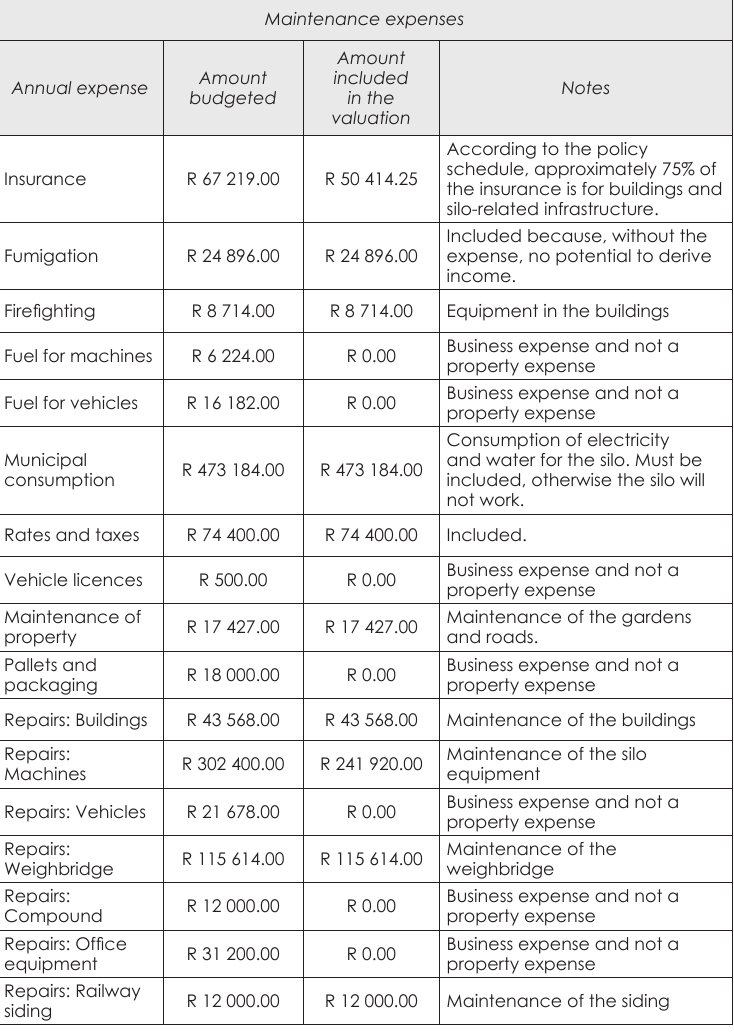
Table 9: Maintenance expenses to deduct 1